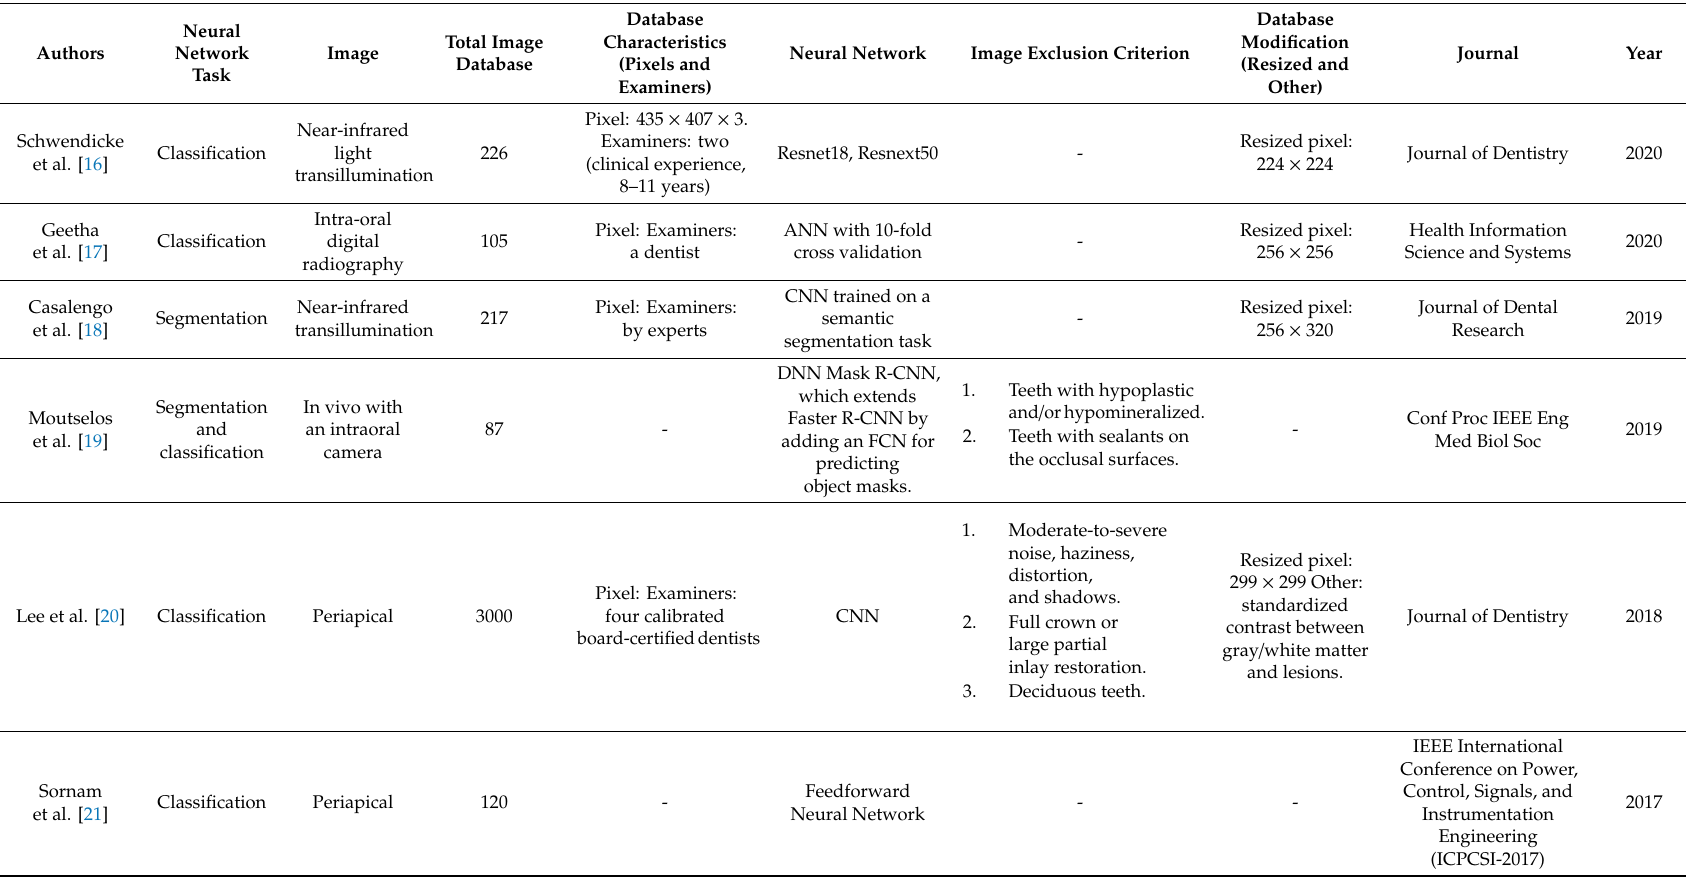
Table 2. Main characteristics of image database and neural